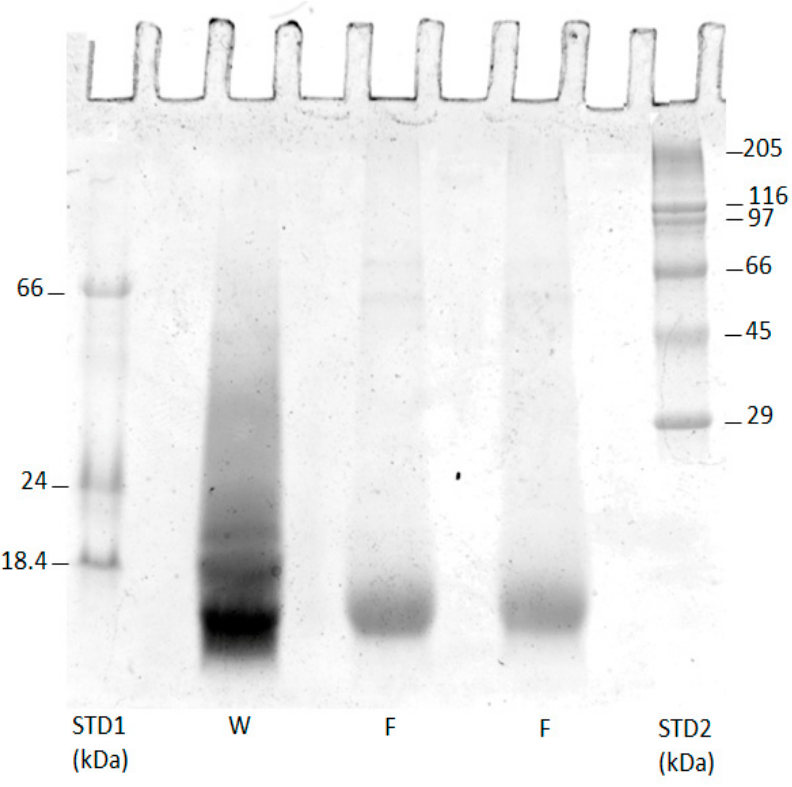
Figure 3. SDS-PAGE of keratin analysis. The first and last columns show the protein standard and keratin extracted from wool (W) and chicken feathers (F) using sodium metabisulfite as reducing agent.